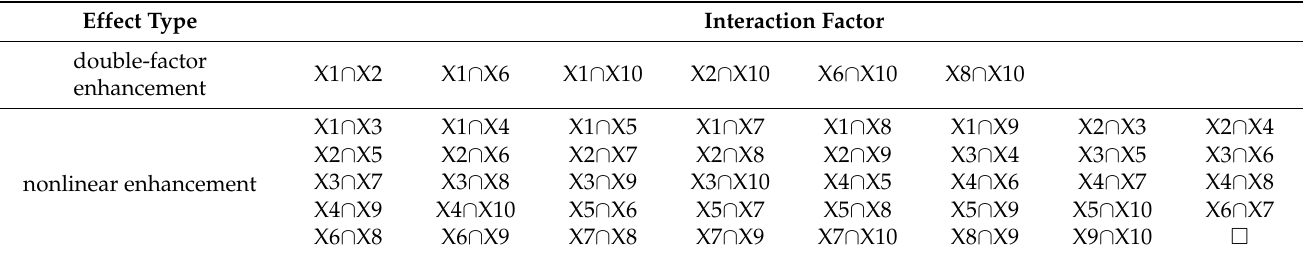
Table 8. Key interactions between driving